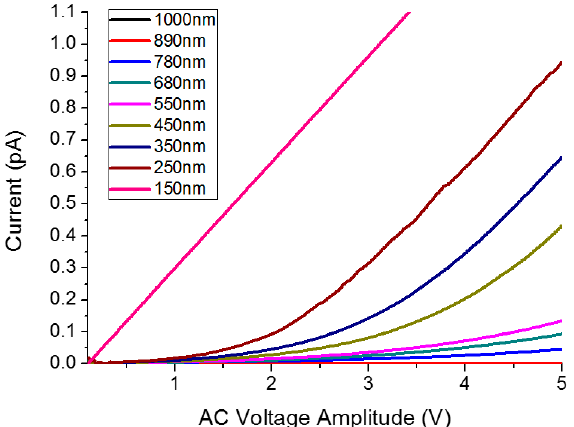
Figure 5. Series of I–V curves over the resistor sample recorded while changing the tip-sample distance. The non-linear behavior due to the tip-sample capacitance is observed for distances greater than 150 nm.